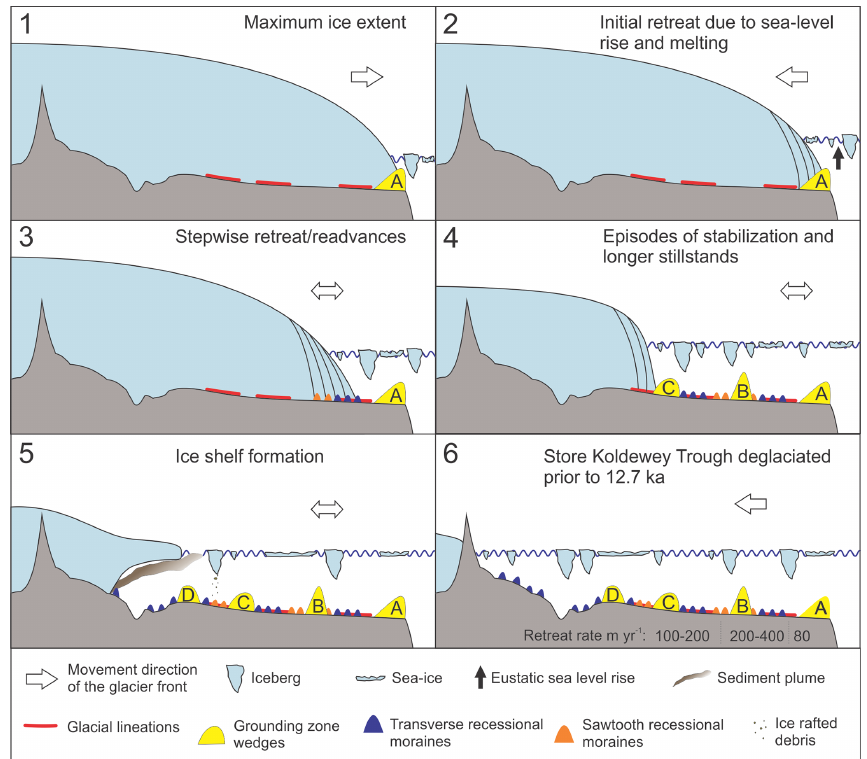
Figure 9. Reconstruction of the ice sheet dynamics in Store Koldewey Trough. Stages 1–6 show the maximum ice extent of the ice stream, as well as the ice stream margin positions during the following deglaciation. Icebergs and sea ice indicate iceberg calving and ice rafting. The deglaciation age in Stage 6 is based on cosmogenic nuclide dating on Store Koldewey Island (Skov et al.,